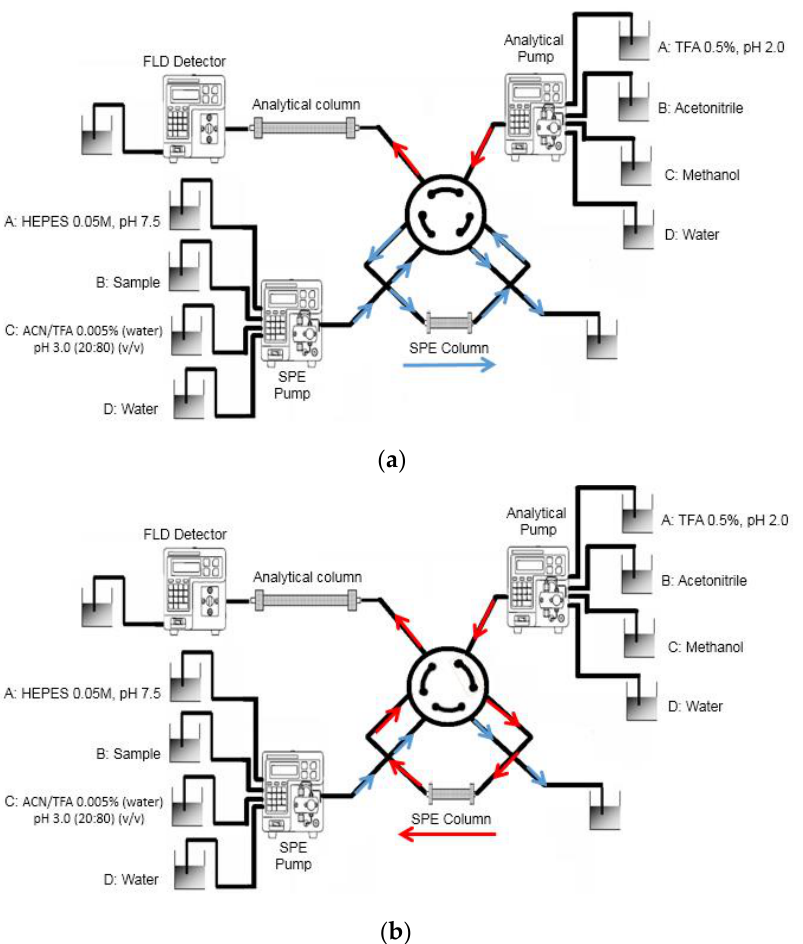
Figure 2. Scheme of the online MISPE-HPLC set-up. ( a ) Valve position A: sample loading; ( b ) valve position B: sample analysis.